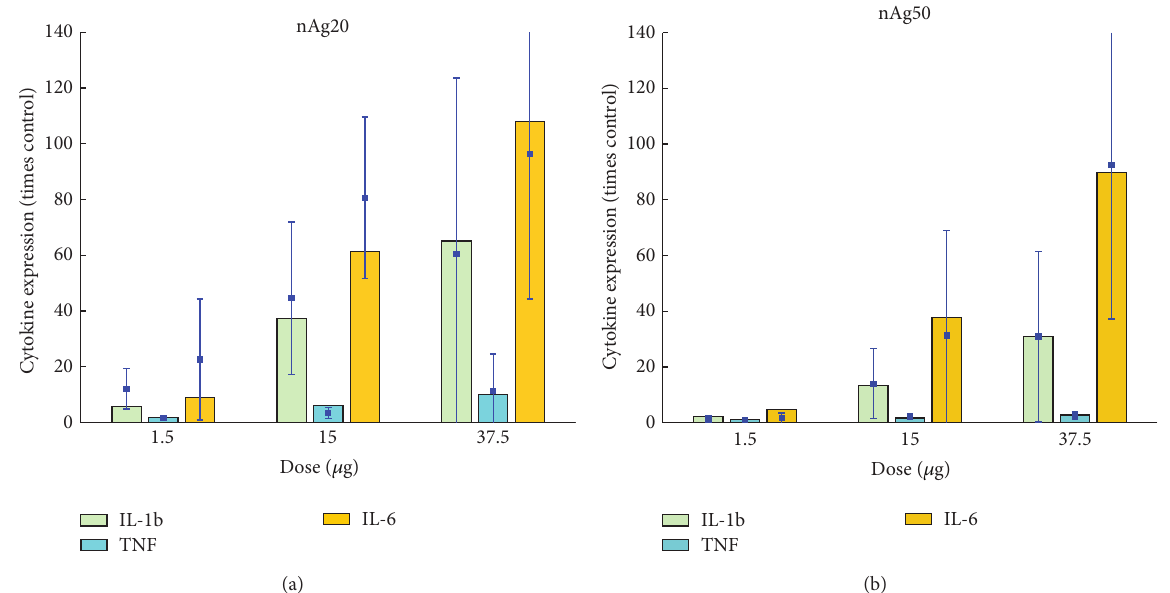
Figure 7: Comparison of model predictions and measured values of proinflammatory cytokine levels in culture medium after 4 hours for human MDMs with different doses of 20 nm (a) and 50 nm (b) nAg in vitro . Bars represent model predictions and squares and error bars represent in vitro measurements.